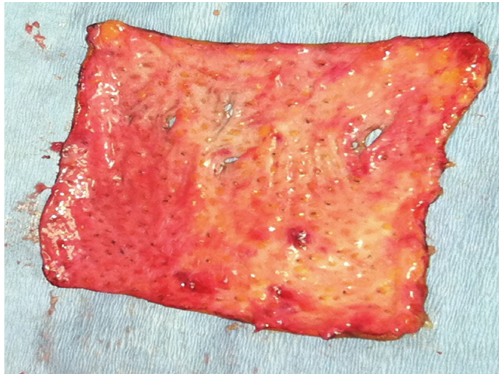
Figure 3: The harvested full skin graft measuring 7 × 7cm.